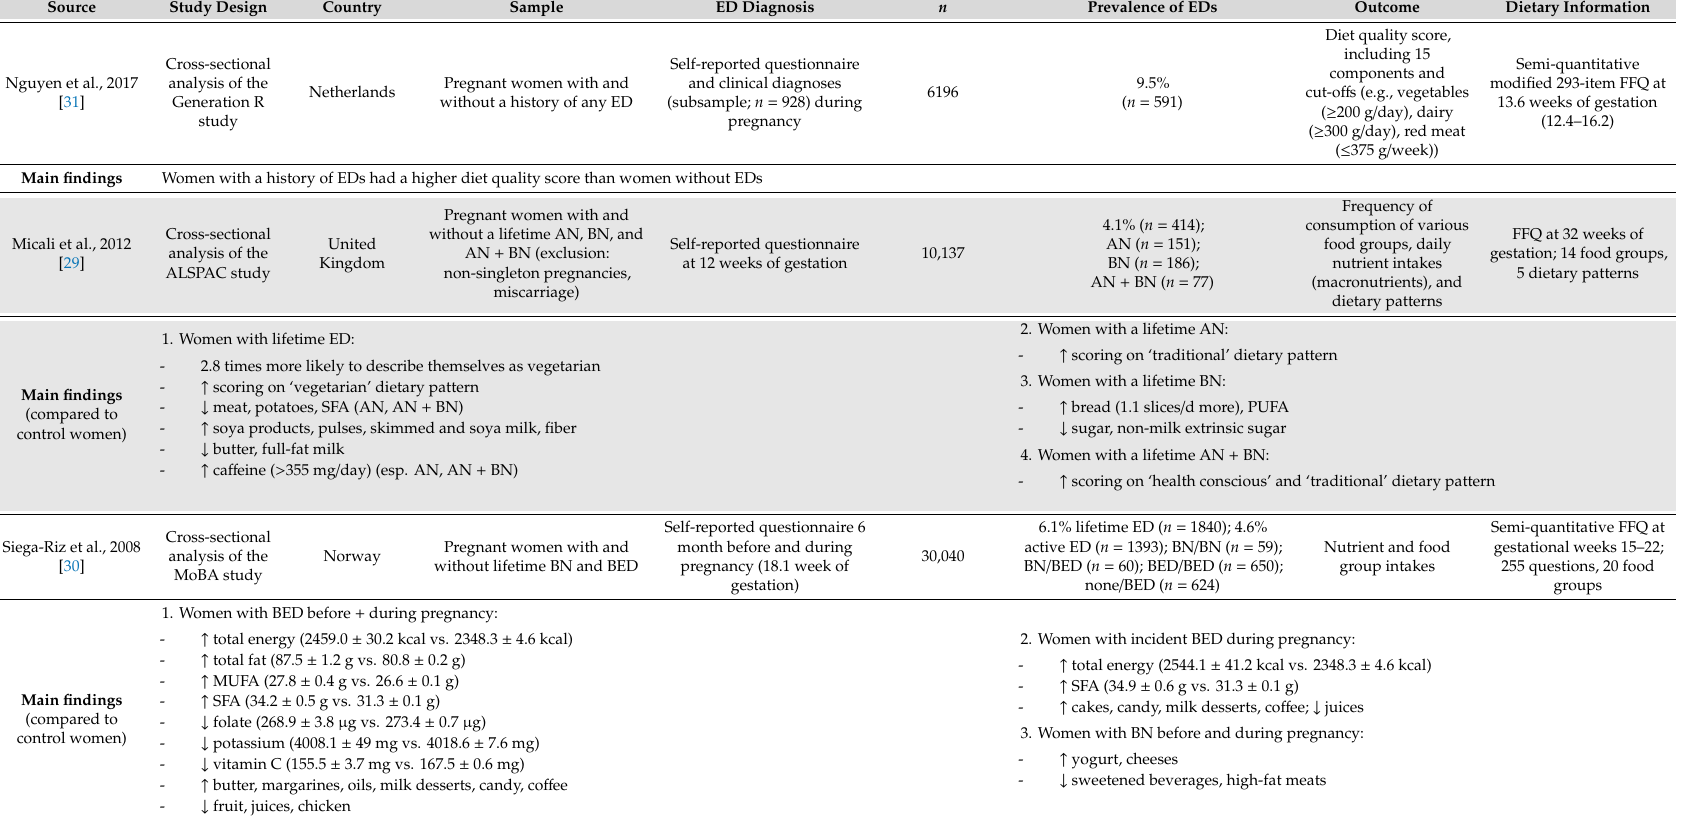
Table 1. Studies investigating dietary intake / quality / patterns in pregnant women with eating disorders.